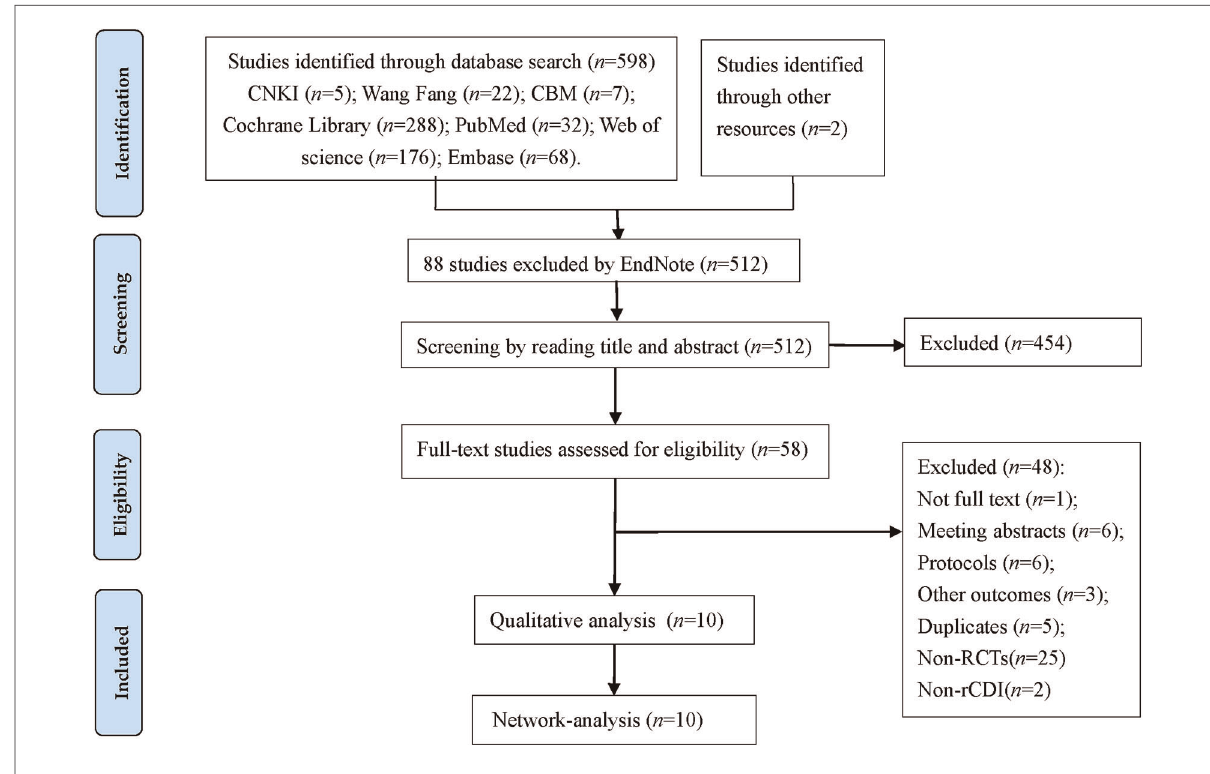
FIGURE 1 The fl ow chart of literature searching and screening